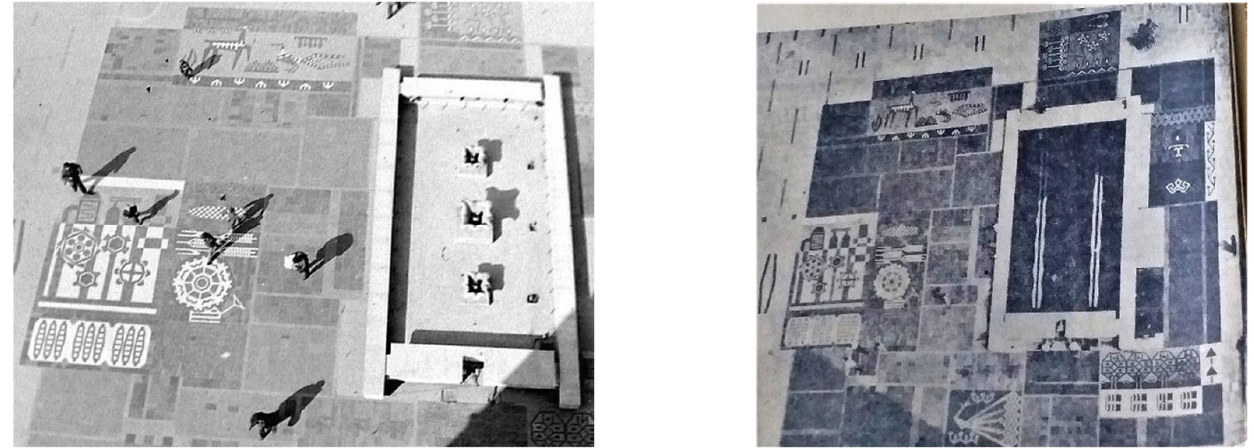
Figure 1. The pavement mosaic in the Central Square of Suceava